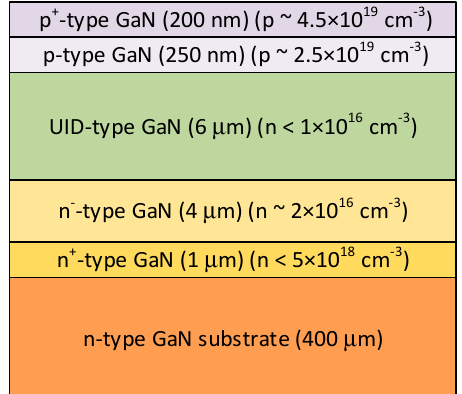
Figure 1. The epitaxial layer structure of the PIN rectifier grown at Georgia Tech on a NEAT GaN substrate.